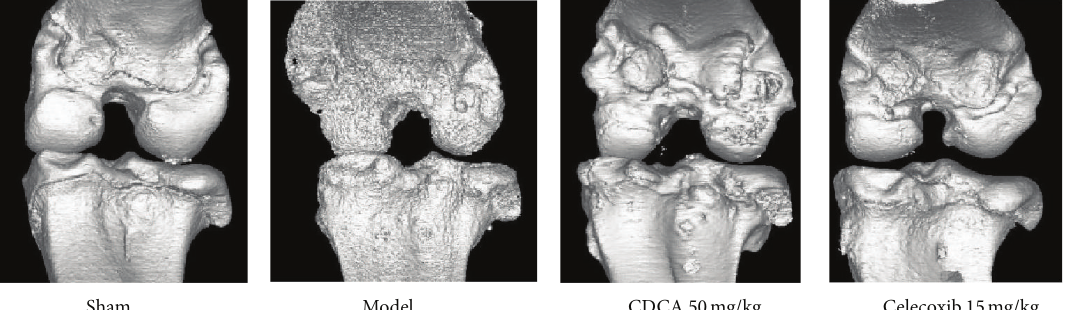
Figure 4: Representative micro-CT images of rabbit knee joints are